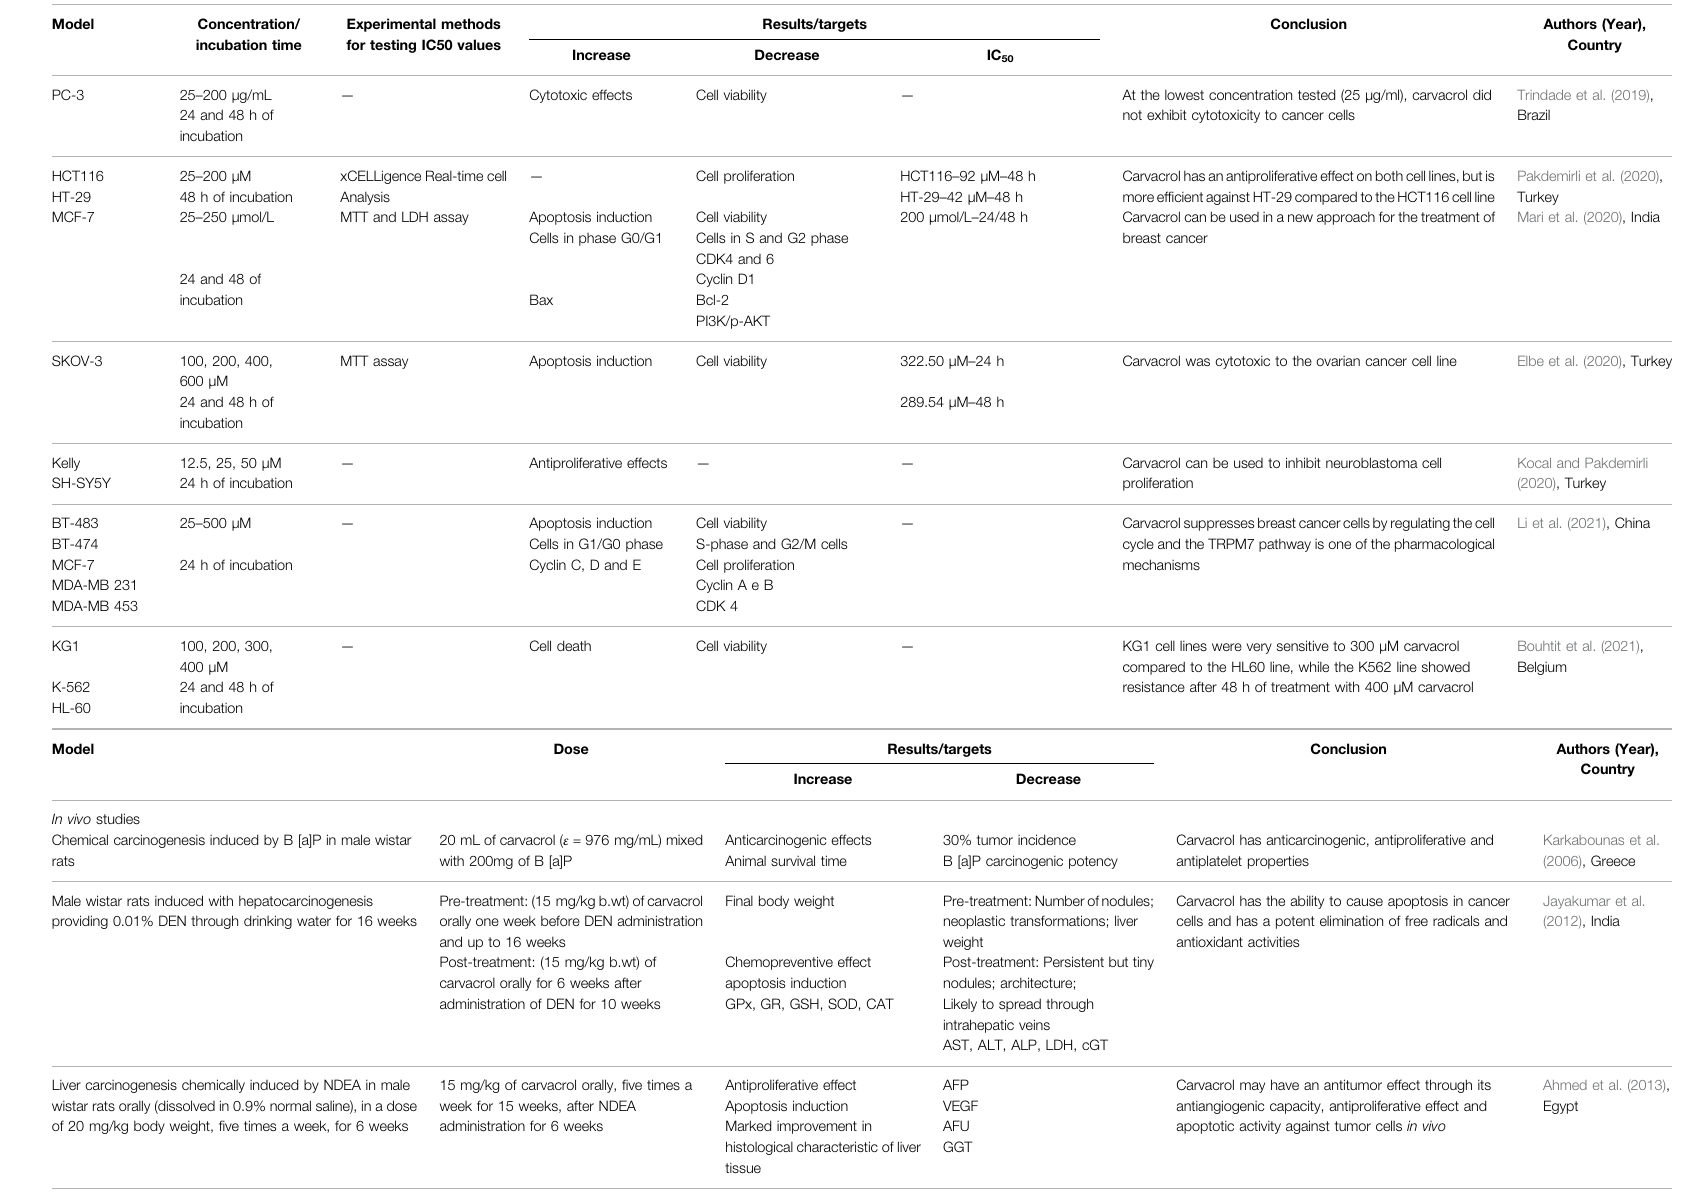
Pre-treatment:Numberofnodules; neoplastic transformations; liver